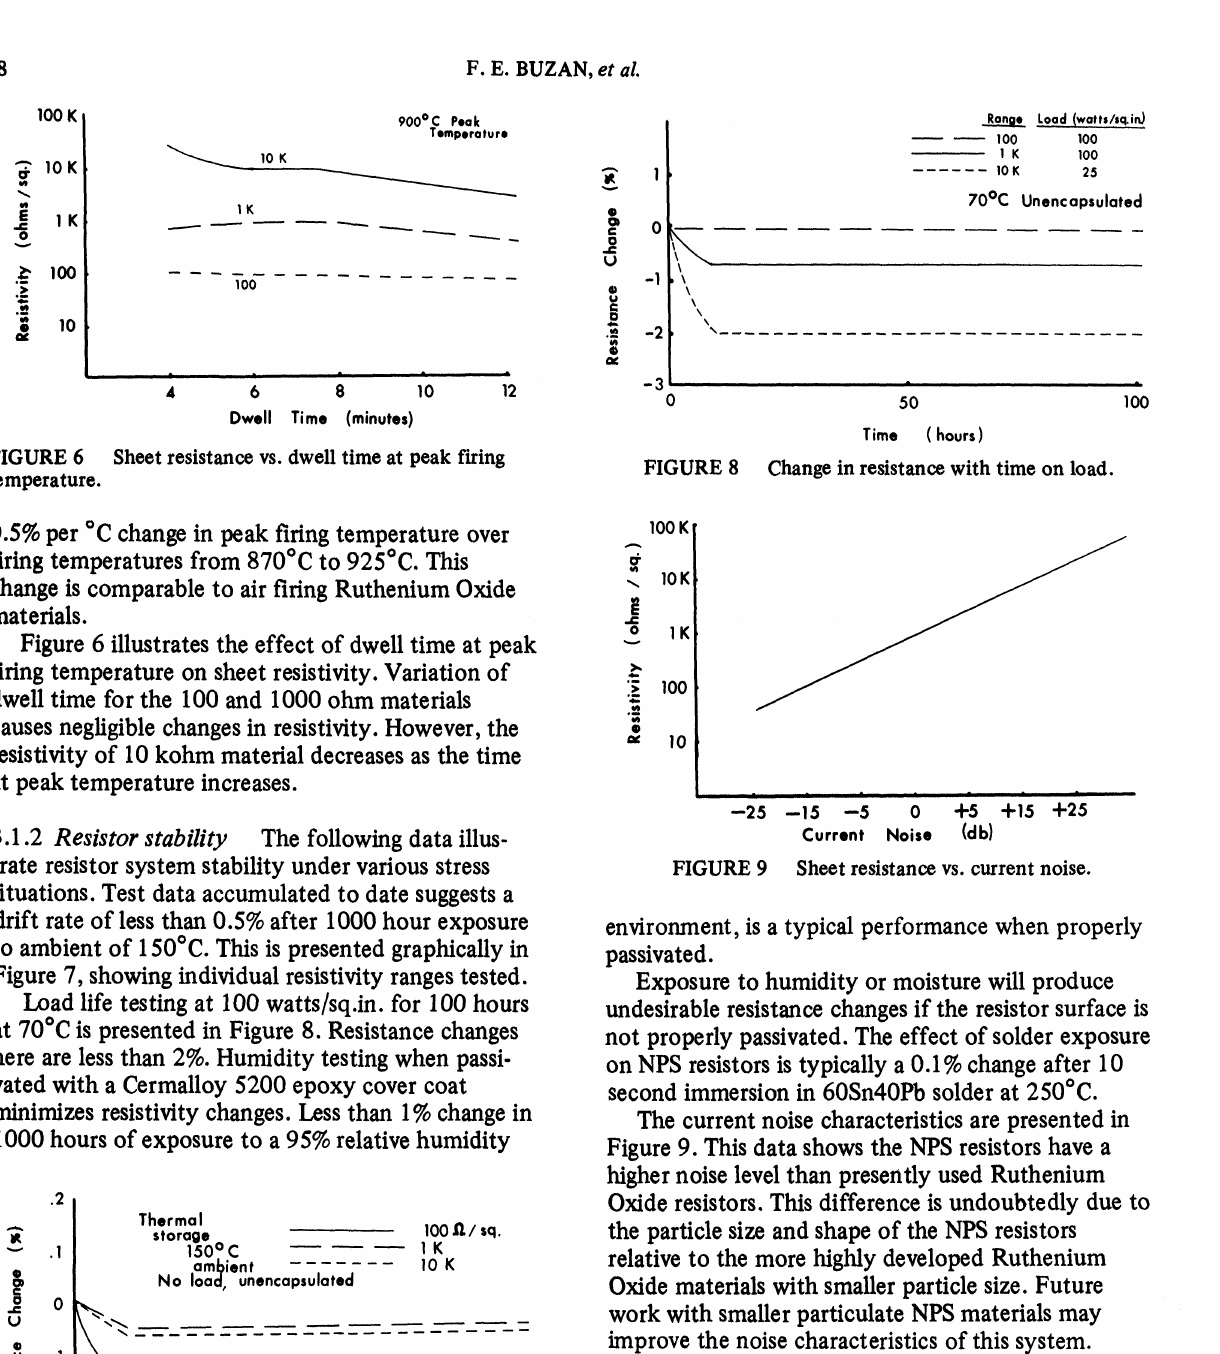
FIGURE 7 Effect of various stress environments on resistance.